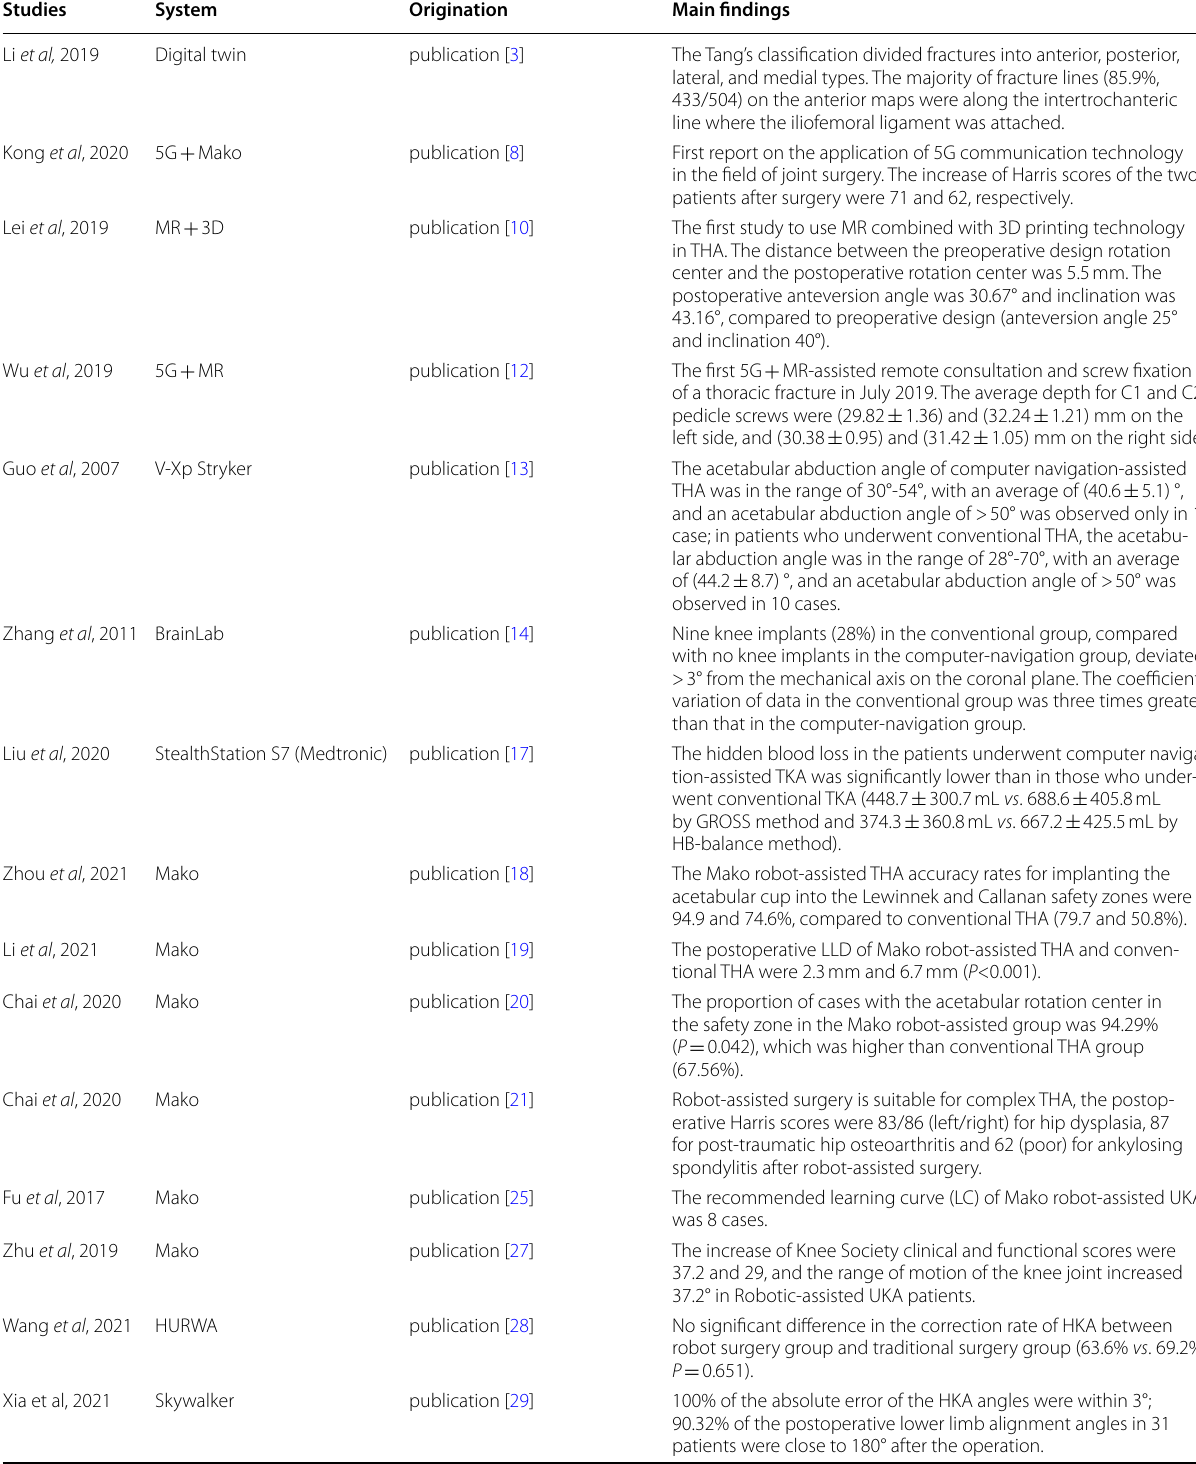
Table 1 Summary of artificial intelligence assisted joint surgery in China in 2021